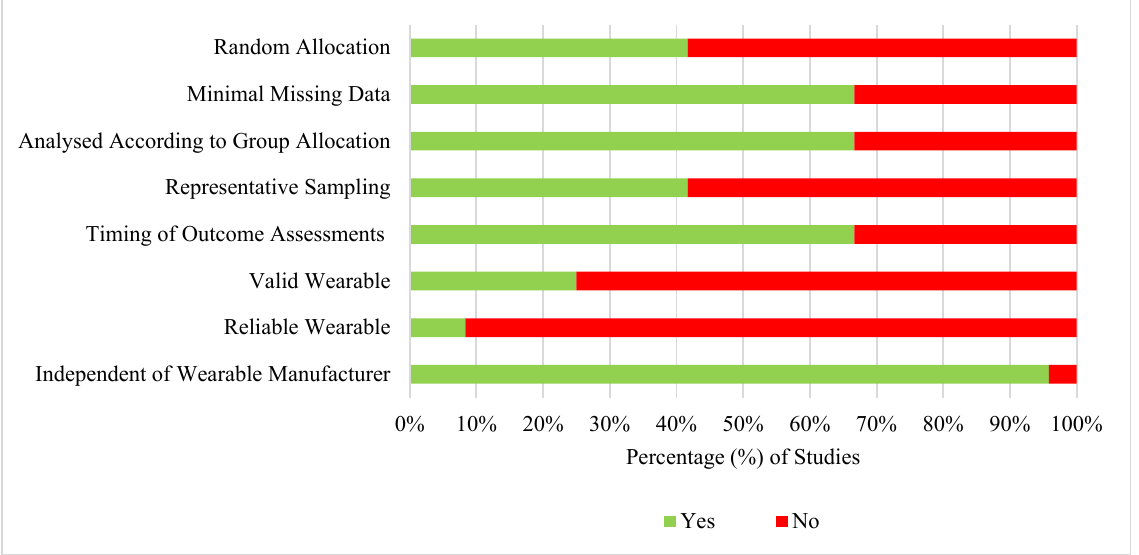
Figure 2. Summary of the risk of bias results across all criteria for effectiveness studies ( n = 24). Table 3. Risk of bias results for individual effectiveness studies.